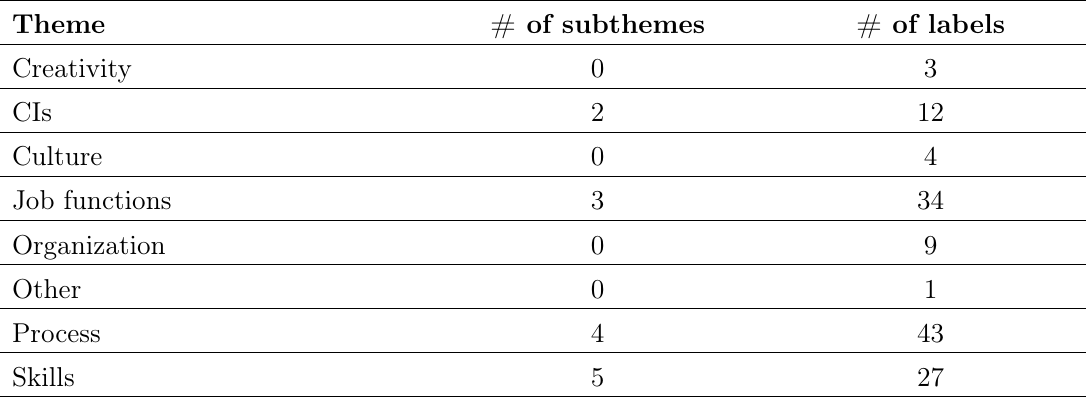
Table 2. Themes of the codebook with the number of subthemes and labels Theme # of subthemes # of